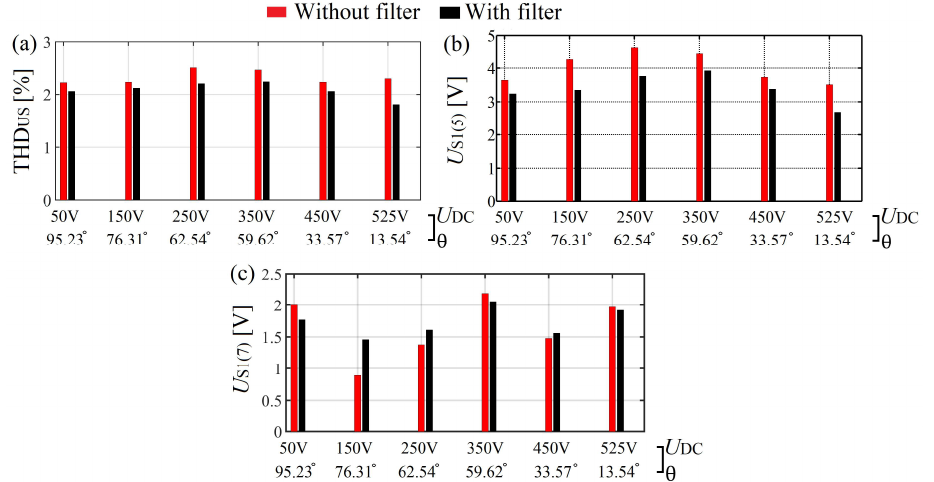
Figure 19. ( a ) Grid voltage THD; grid voltage 5th ( b ) and 7th ( c ) harmonic amplitudes before and after the filter connection.